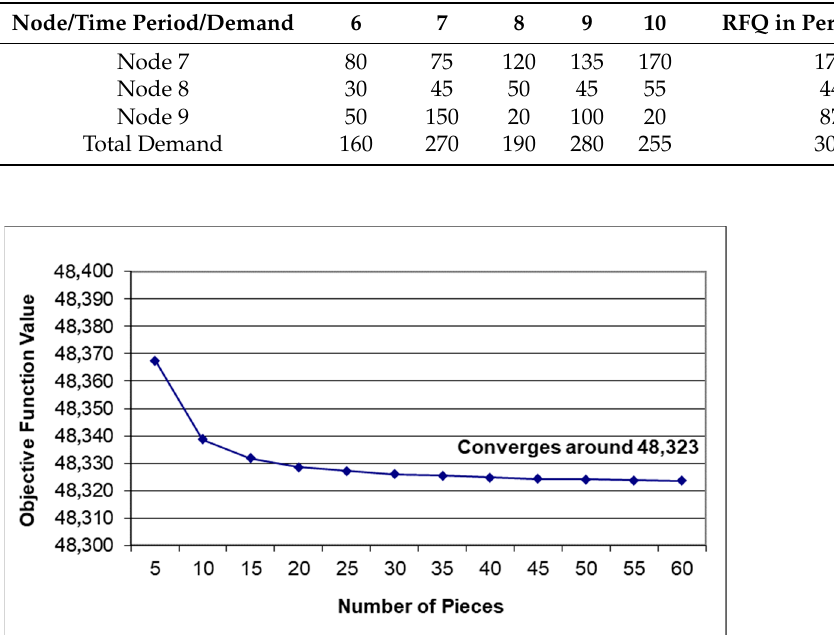
Table 8. Demand data for DPPNL computations.